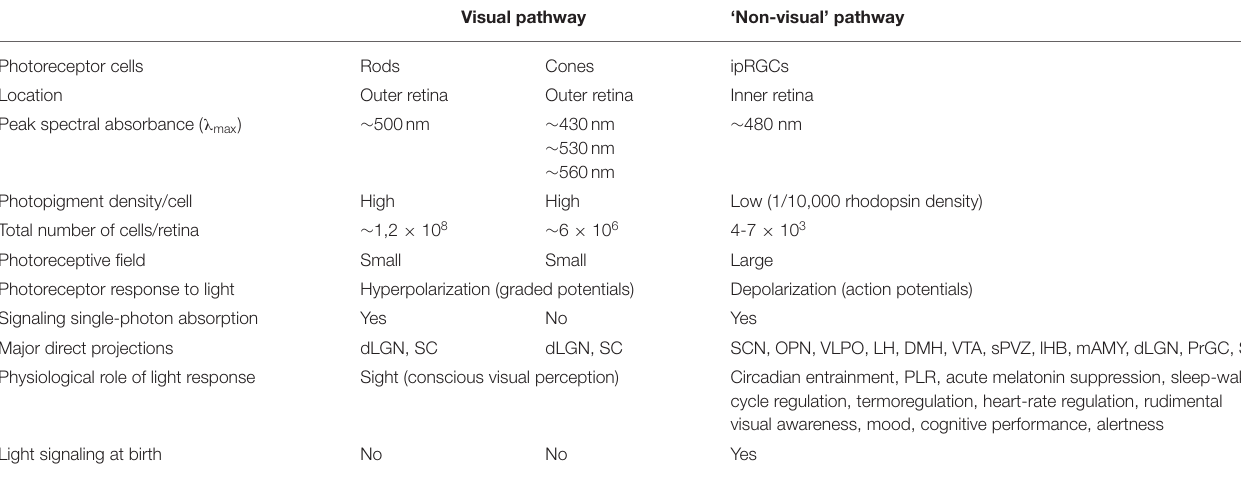
TABLE 1 | Human visual and “non-visual” photoreceptive systems.